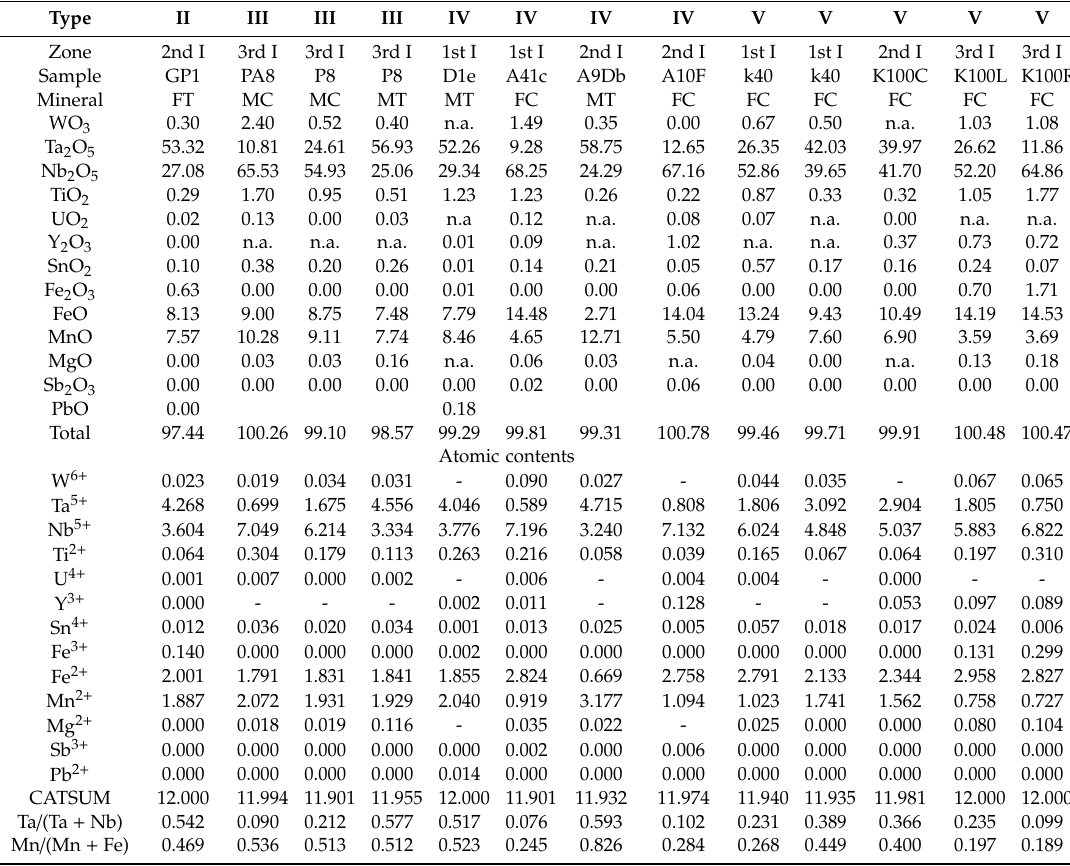
Table 2. Representative chemical composition of CGM from the Gira ú l pegmatites. FT,